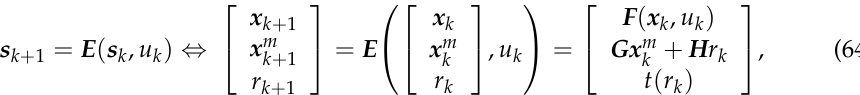
is in black line in bottom k